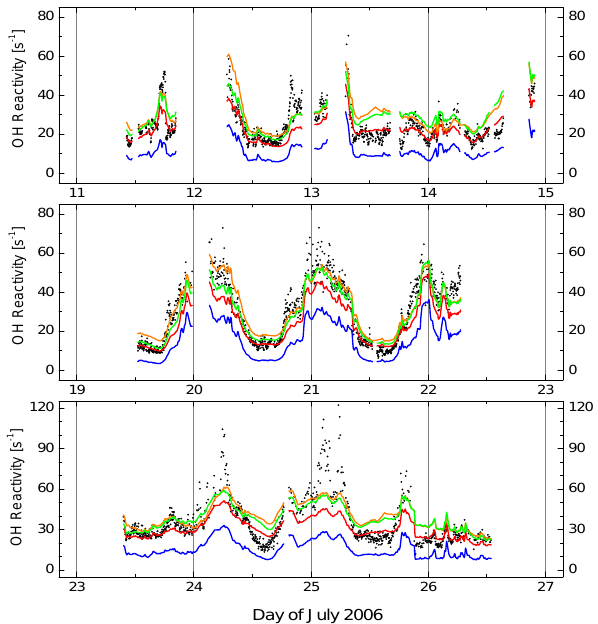
Fig. 4. Comparison of measured, calculated and modelled k OH data at 1atm and 313K. Dots: measured values. Blue line: k calc values OH calculated from measured trace gases (CO, NO x , hydrocarbons). Red line: model results, k model (RACM, base case). Green line: OH (RACM, plus additional recycling by X). Or- model results, k model OH ange line: base case model using measured OH concentrations as an Fig. 5. Upper panel: diurnal variation of measured total OH reac- additional model constraint. Vertical lines denote midnight. Note tivities at PRD for the days of 11–26 July 2006. Individual k OH data are represented by gray dots and their half-hourly mean diur- nal profile by the solid line. Lower panel: cumulative reactivities contributed by measured trace gases, normalized to the measured k OH : CO (triangles), CO + NO x (open circles), CO + NO x + hy- drocarbons (squares). The time of day is given in Chinese Standard Time (CNST=UTC+8h), with solar noon at 12:30